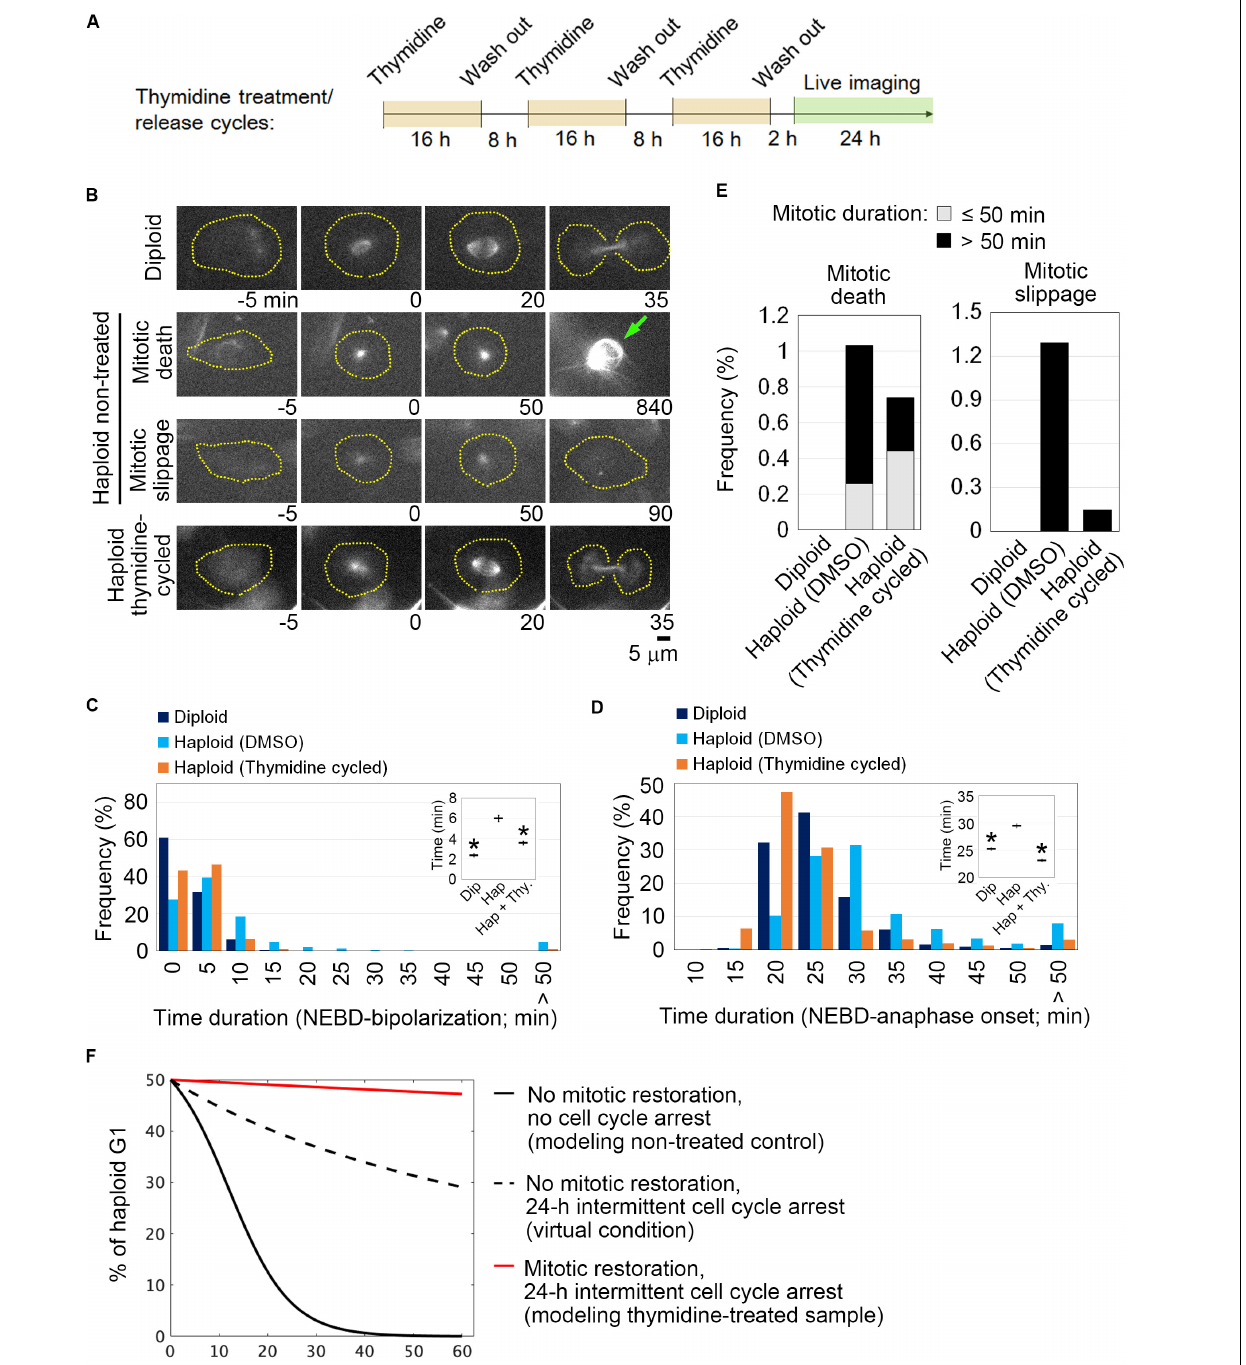
Frontiers in Cell and Developmental Biology |